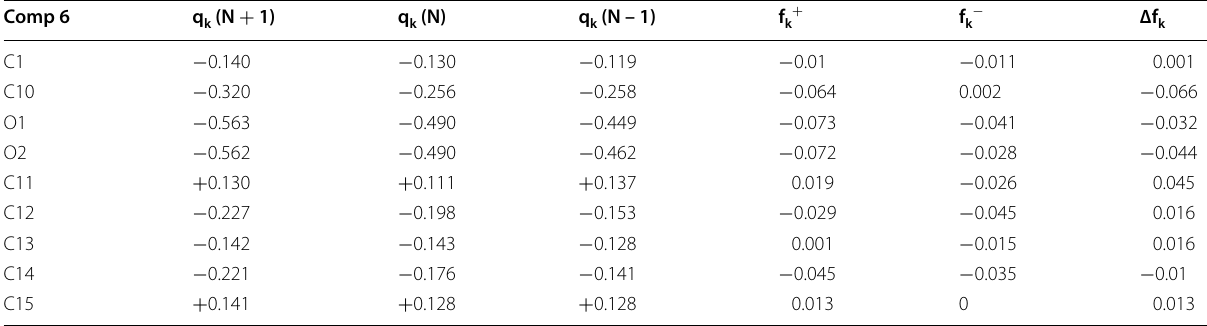
Table 7 Selected Mulliken atomic charges and Fukui functions for Compound 6